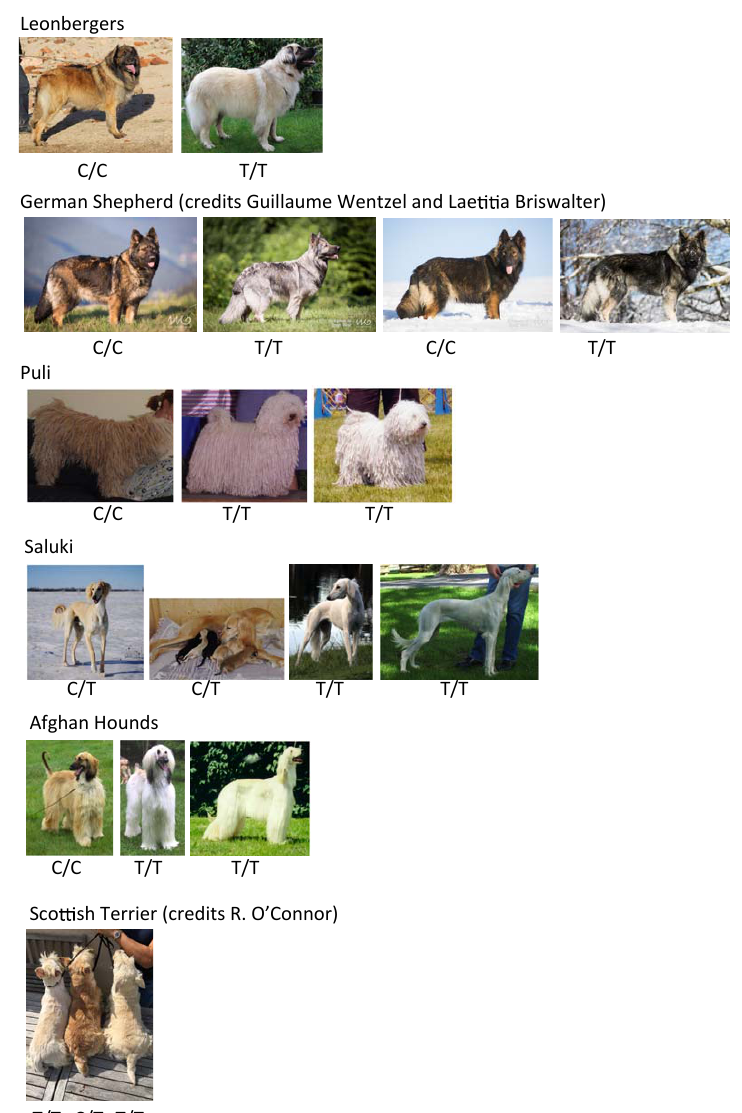
Figure 4. Photos and MFSD12 genotypes of relevant tested breeds